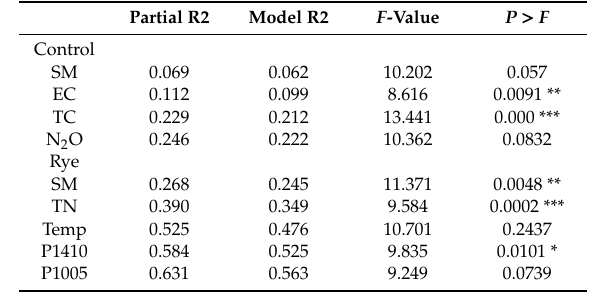
Table 7. Results of stepwise multiple regression analysis showing the influence of di ff erent factors (N 2 O: nitrous oxide emissions; SM: soil moisture; Temp.: soil temperature; EC: electrical conductivity; MBC: microbial biomass carbon; TN: total nitrogen; TC: total carbon; P1005: relative absorbance of the FTIR peak for silicates and clay minerals as well as C–O–C stretching in polysaccharides; P1410: relative absorbance of the FTIR peak for C–O bond vibrations and also the vibrations in C–N (amide III); P2920: relative absorbance of the FTIR peak for asymmetric C–H vibration of aliphatic compounds) on water-stable aggregates within di ff erent treatments after 105